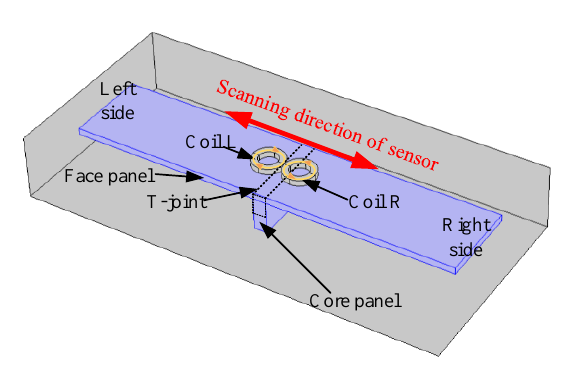
Figure 2. The scheme for eddy current sensor scanning to locate the center of core panel.